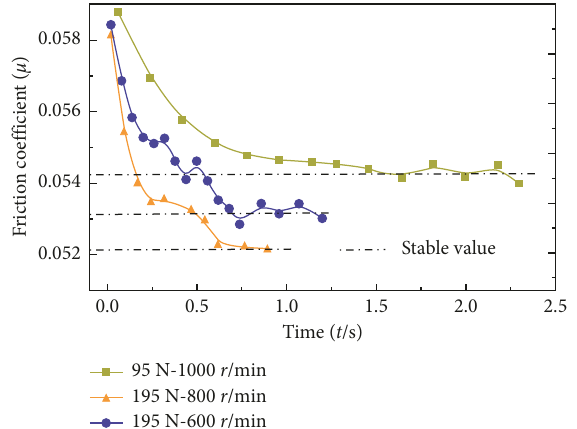
Figure 11: Variation law of friction coefficient of the friction cone under different working